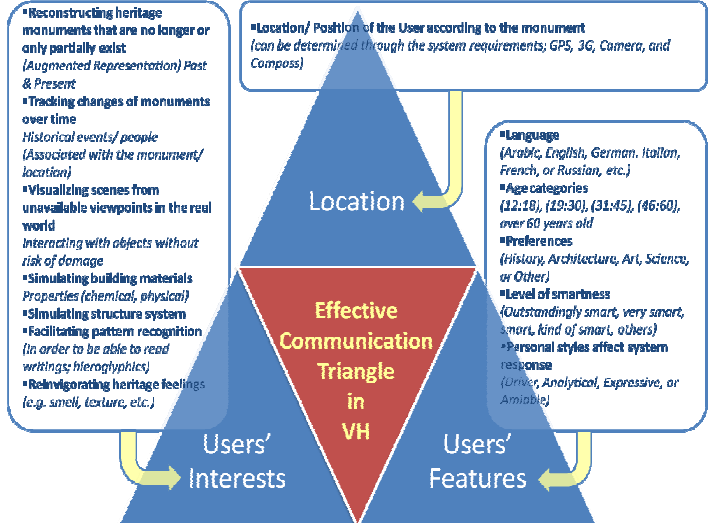
Figure 11. The proposed effective communication triangle approach for virtual heritage.